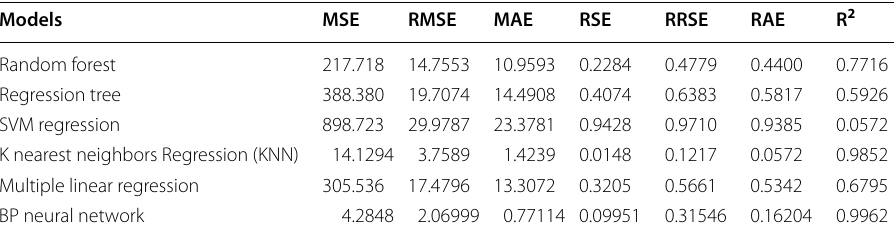
Table 5 Performance comparison between proposed ANN based model and traditional